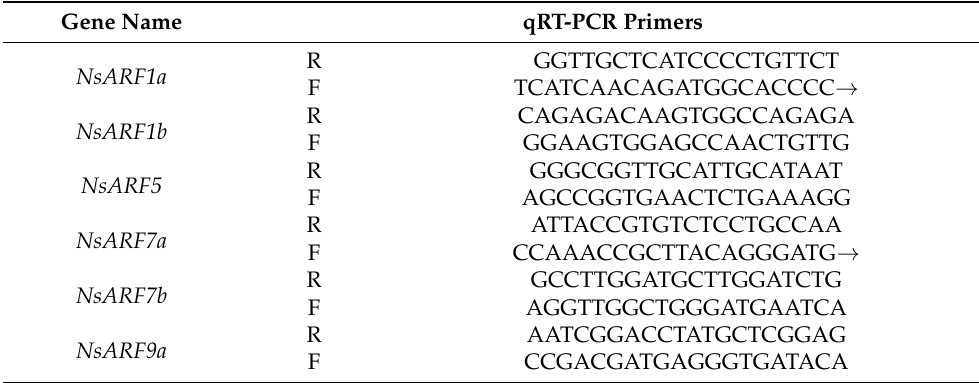
Table 4. qRT-PCR primers used to quantify NsARF gene